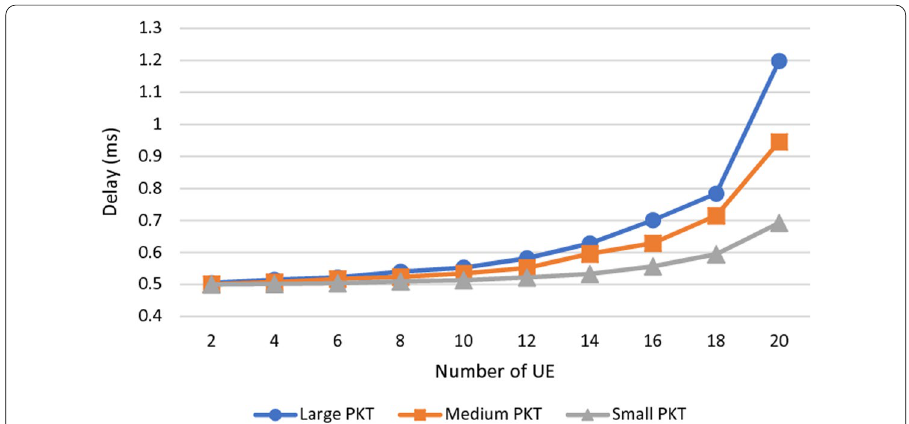
Fig. 18 Analysis of delay in different packet size situations; The performance analysis of delay in different packet sizes for our proposed EURA scheme